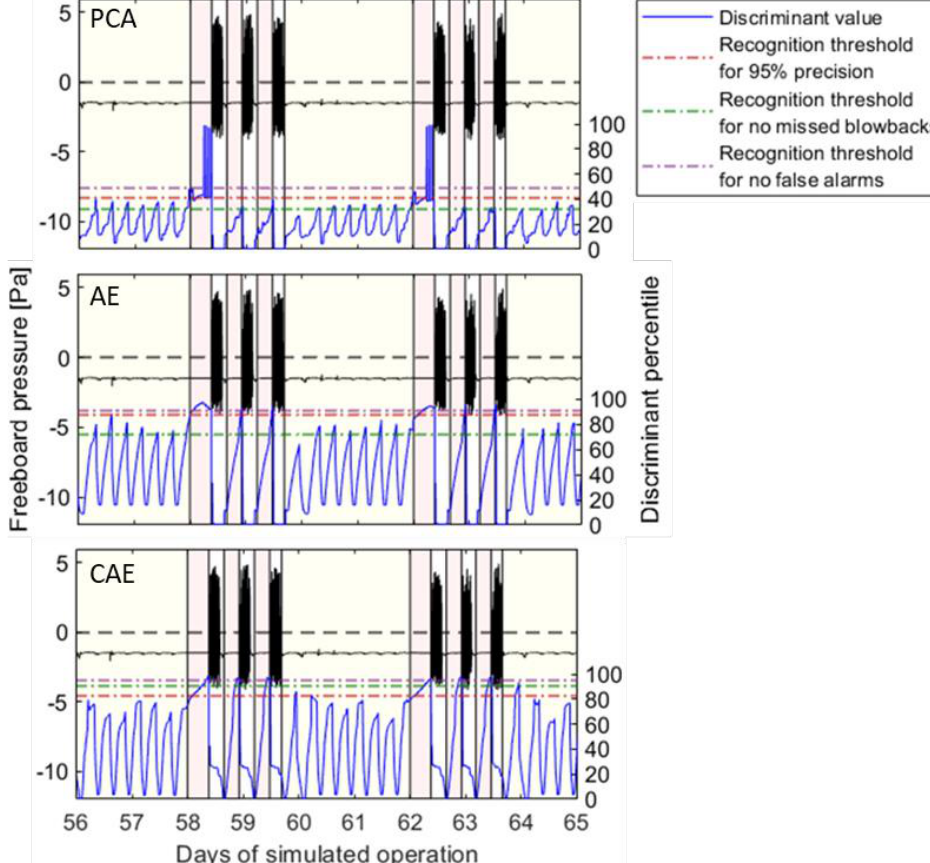
Figure 12. Illustration of dPCA- (top graph), AE- (middle graph) and CAE-fault pattern recognition for 9 days of simulated operation. The areas shaded in gold indicate fault-free observations, red areas indicate blowback-preceding observations. The blue line is the discriminant value generated by each model, and the solid black line indicates freeboard pressure. The black dashed horizontal line indicates zero gauge pressure. The coloured dashed horizontal lines correspond to the different recognition thresholds defined in Table 8.